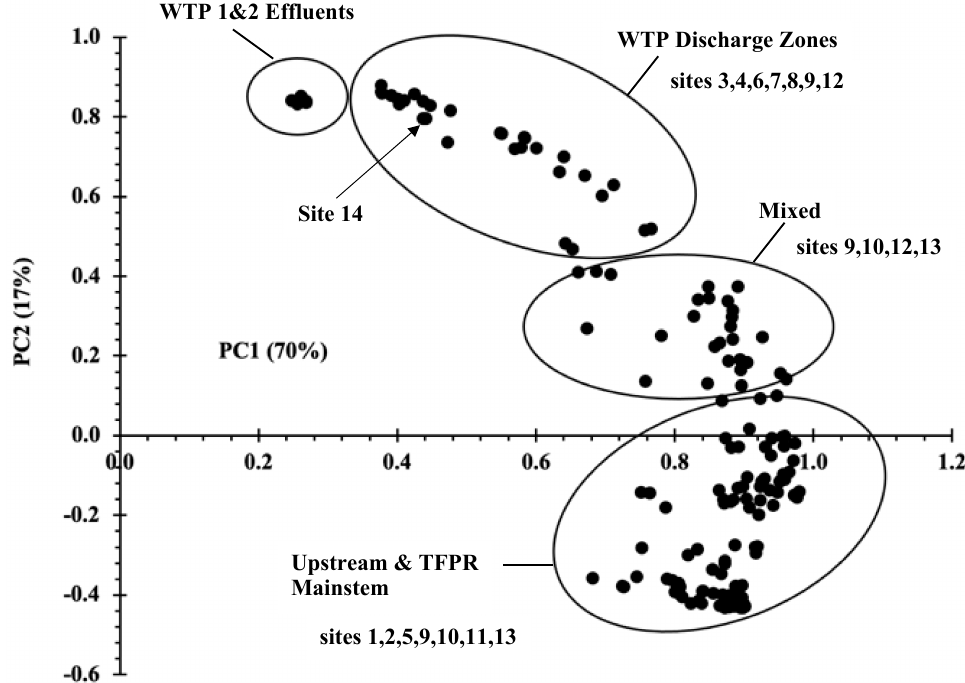
Figure 3. PCA loadings plot of PPCP composition across all tidal freshwater Potomac River sam- pling sites.